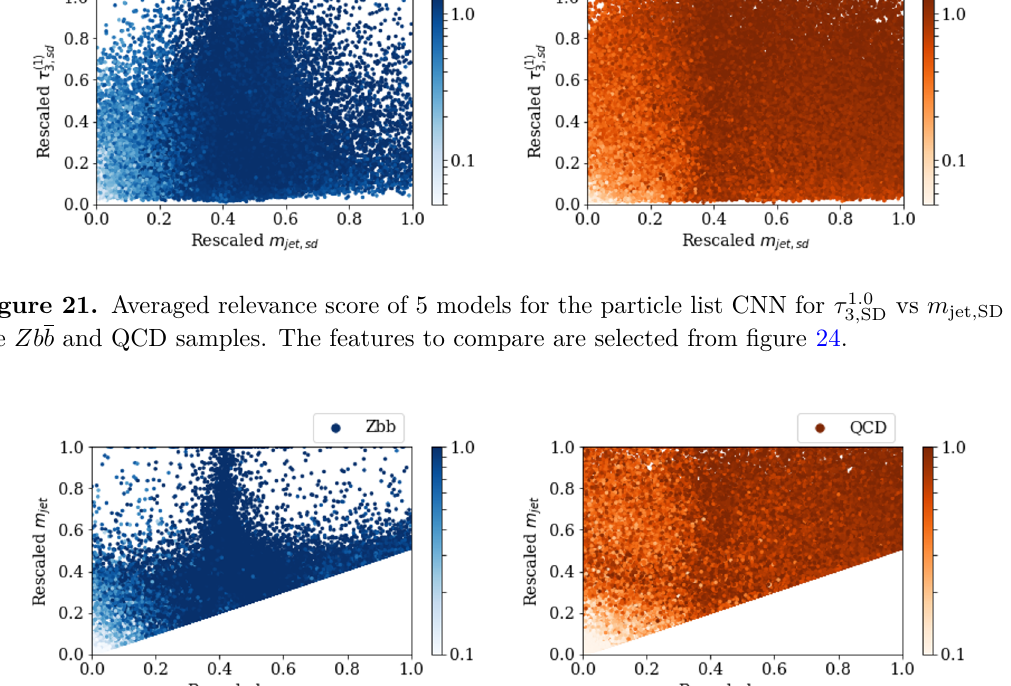
Figure 22. Averaged relevance score over 5 models for particle list CNN for ungroomed mass m jet vs groomed mass m jet , SD for the Zbb and QCD